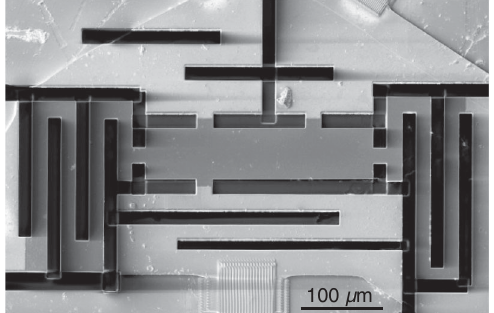
FIG. 12. SEM image of a microstructured PtCoO 2 sample used for the ex situ measurements of the temperature- and magnetic field-dependent resistivity.